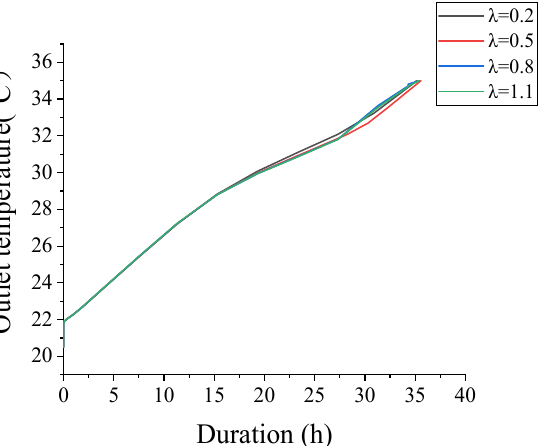
Figure 13. Effect of thermal conductivity on the outlet temperature of the reservoir. It can be seen from Figure 13 that the thermal conductivity has no obvious effect on the outlet temperature of the reservoir, and the four curves almost coincide. However, in the phase change heat storage stage, when the thermal conductivity is 0.2 W/m · K, the slope of the temperature rise in the second stage is higher than under other conditions. The duration of the second stage is longer than under other conditions. The reason is that, when the thermal conductivity value is lower, the melting rate of PCM is slower and the melting duration is longer. As can be seen from the previous analysis, the outlet temperature of the reservoir is significantly affected by the latent heat value and phase change temperature value of the PCM. The influence of thermal conductivity on the heat storage performance of the reservoir is the same under four working conditions in this section. Under the